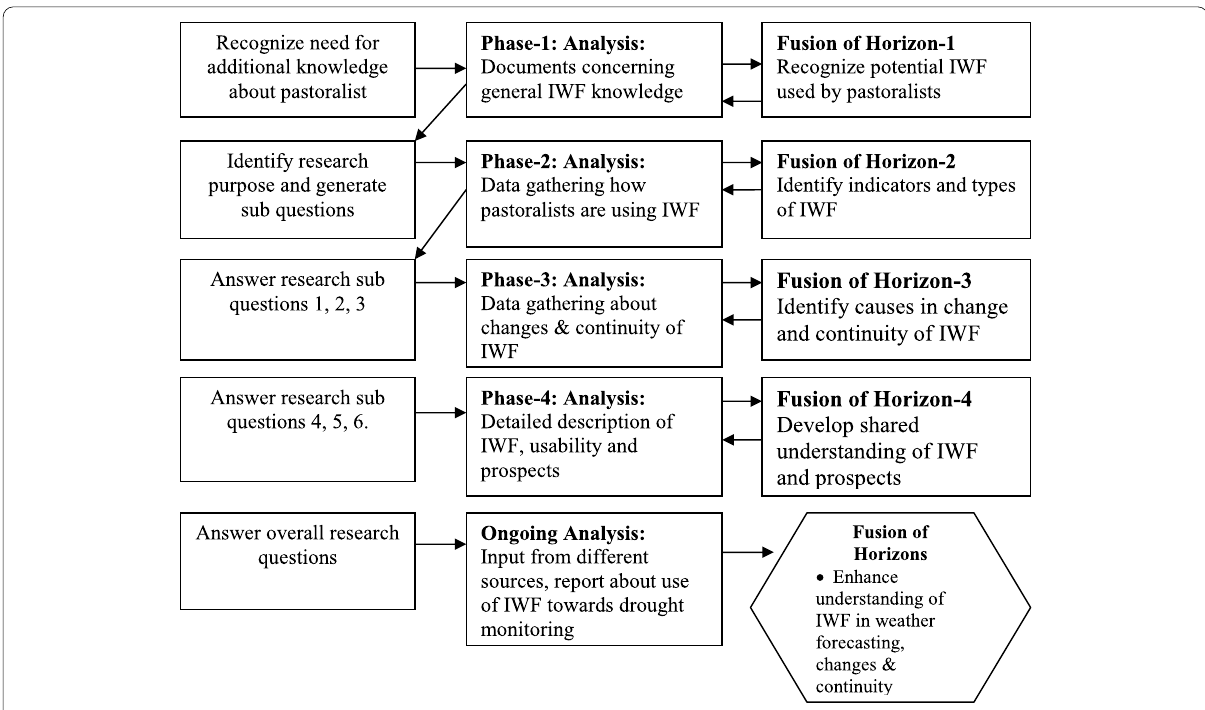
Fig. 1 The hermeneutic spiral approach. Adapted from Paterson and Higgs